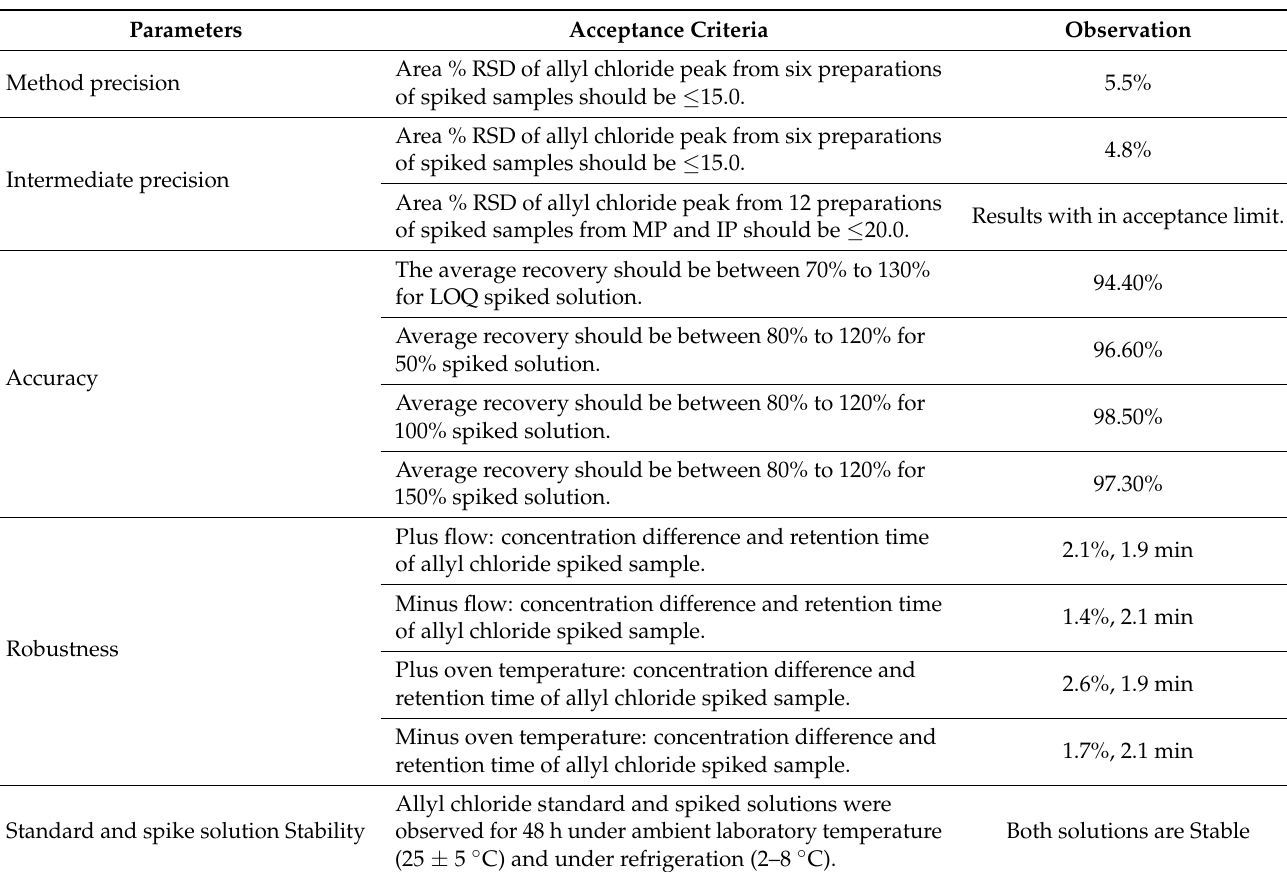
Table 3. Method validation